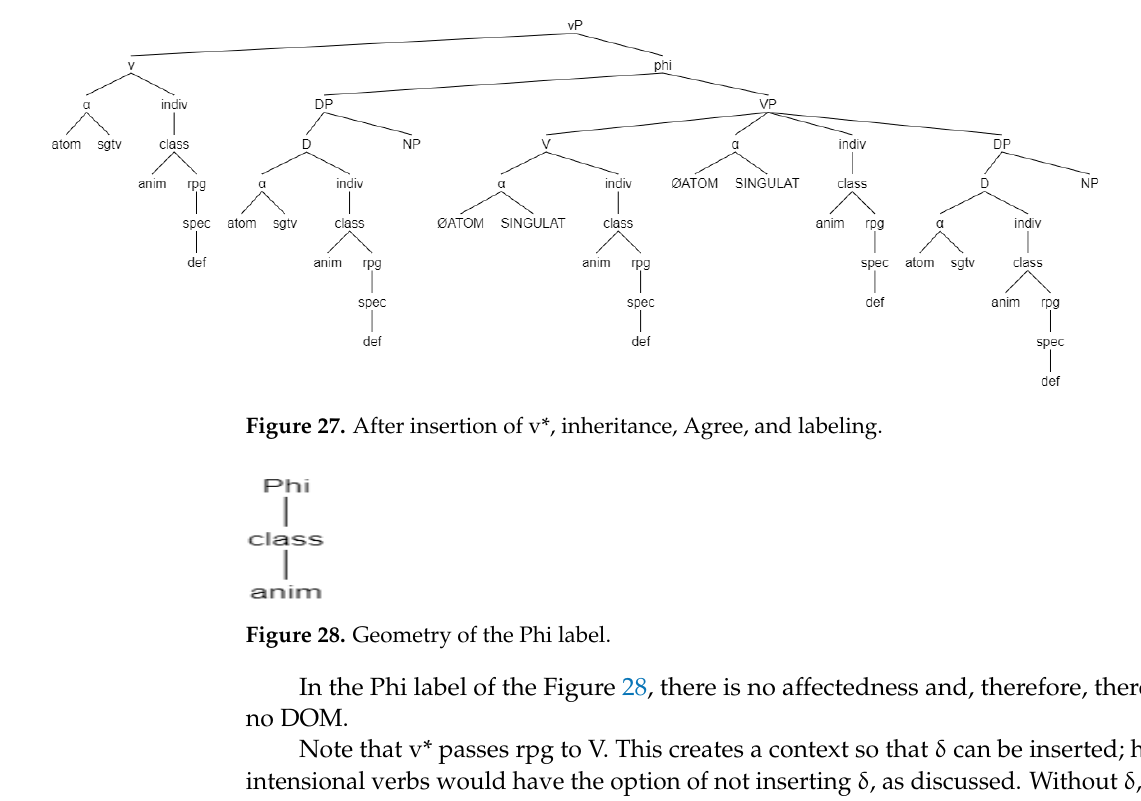
Figure 28. Geometry of the Phi label.